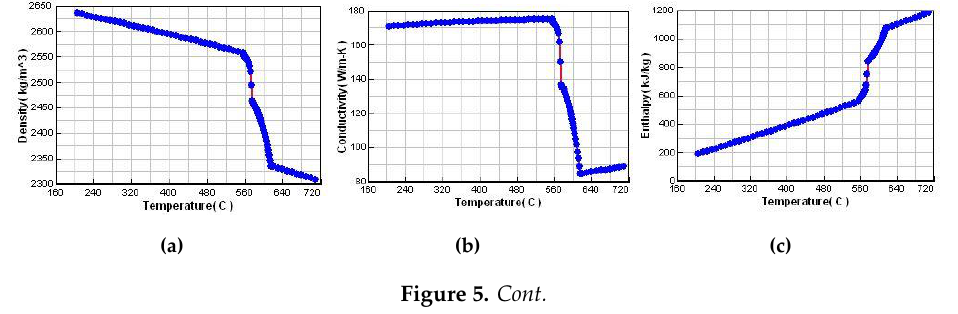
Figure 4. Casting and skeletal sand mold: ( a ) geometric model of the stress frame casting; ( b ) finite element model of the casting; ( c ) skeletal sand mold and ( d ) finite element model of the skeletal sand mold.